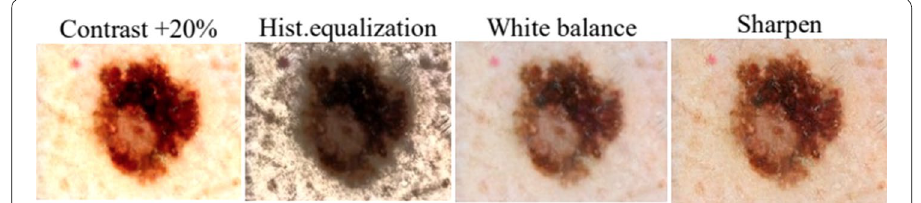
Fig. 3 Examples of Color Augmentations provided by Mikolajczyk and Grochowski [72] in the domain of melanoma